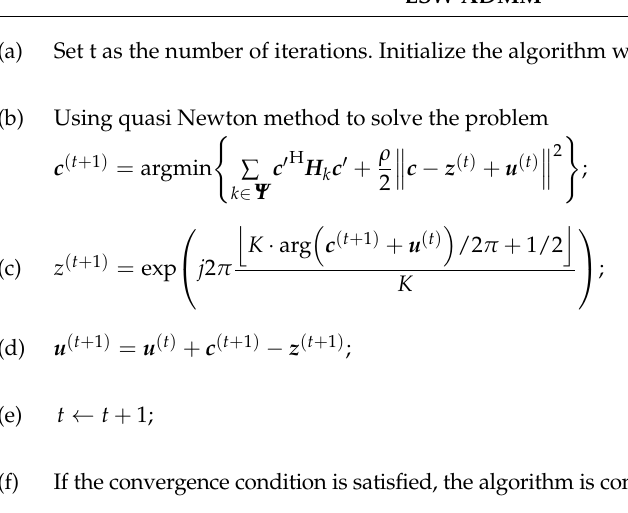
The signal structure of the intra-pulse slice repeater jamming generated by the enemy jammer is shown in Figure 2. The jammer intercepts part of the radar signal in the time domain according to the sampling period to generate the intercepted signal, which can be regarded as multiplying the radar signal with an ideal rectangular pulse with a sampling period of T s and a width of τ 0 to obtain an intra-pulse slice signal. The slice signal is processed by power amplification and delayed-forwarding to generate an intra-pulse slice repeater jamming signal. After the radar receives the intra-pulse slice repeater jamming, multiple deception targets are formed due to the coherence of the repeater jamming.